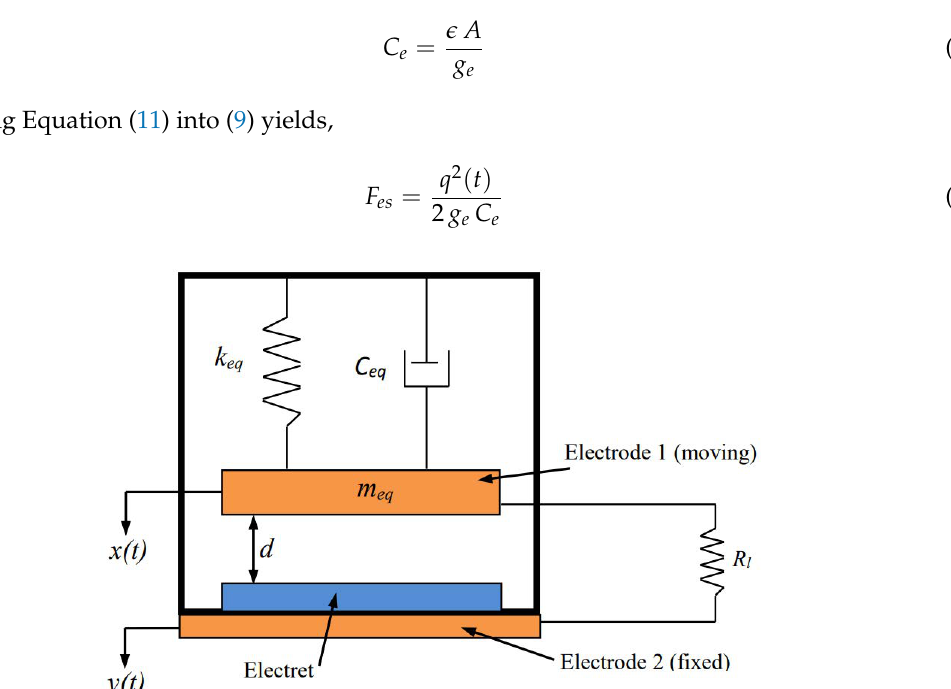
Figure 3. A SDOF model of the electret-based microcantilever energy